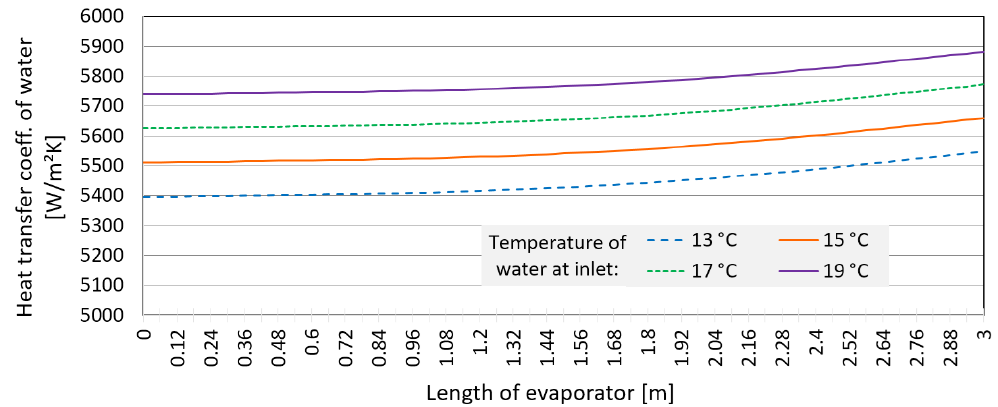
Figure 6. Variation of the heat transfer coefficient of the water.